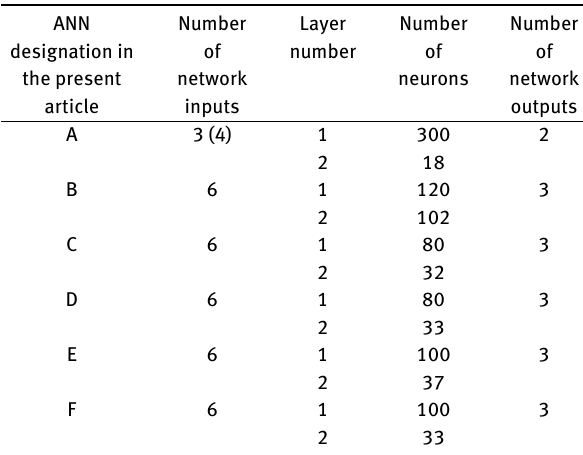
Table 1. The parameters of the artificial neural networks used in the